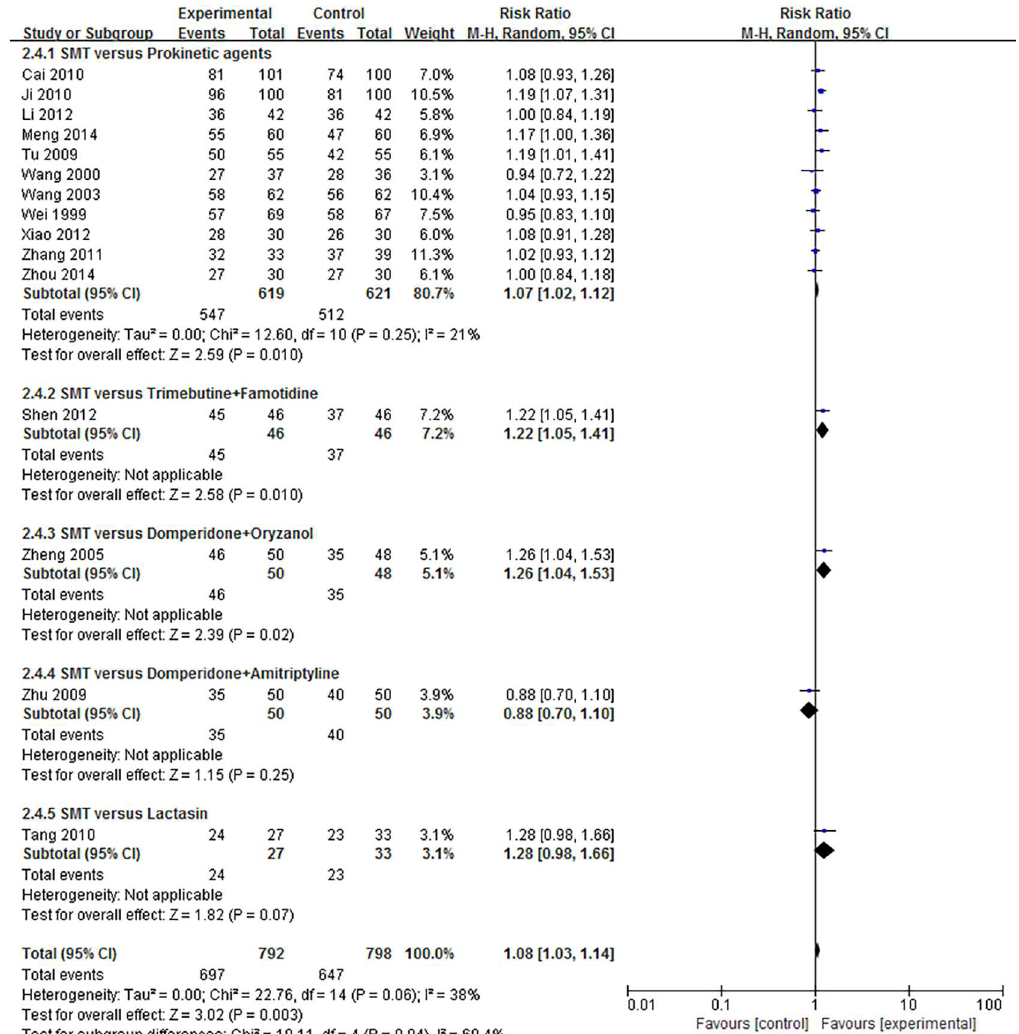
Fig 4. Forest plot of the efficacyrate of SMT-treated FD after subgroup analysis of the different kinds of control interventions among SMT versus WM. SMT = Si-Mo-Tangoral liquid, WM = western medicine, FD = functionaldyspepsia.